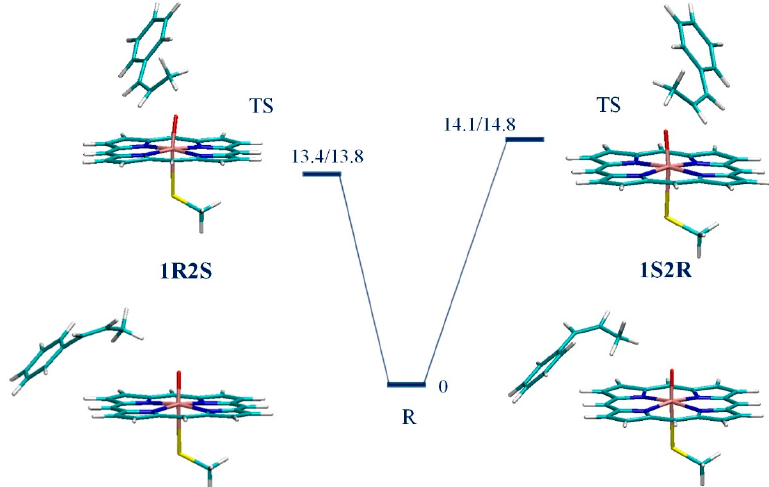
Figure 3. The UB3LYP/B1//B0 potential energy surfaces (in kcal/mol) connecting the reactant states R and the rate-limiting transition states TS leading to the formation of a C β –O bond on the doublet potential energy surfaces for epoxidation of cis- β -methylstyrene (CBMS) by CPO-I-A to give 1R2S and 1S2R products.